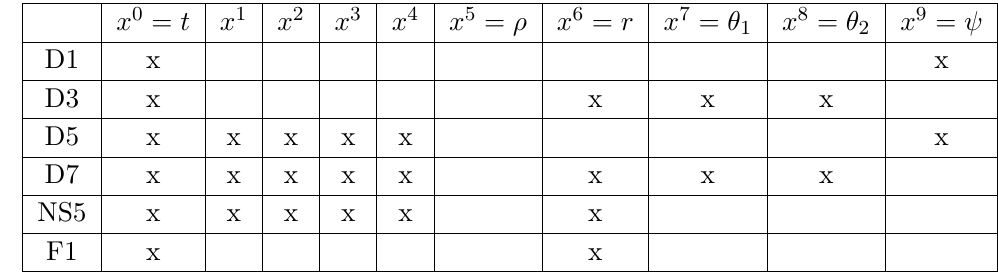
and x 7 , x 8 are the 2